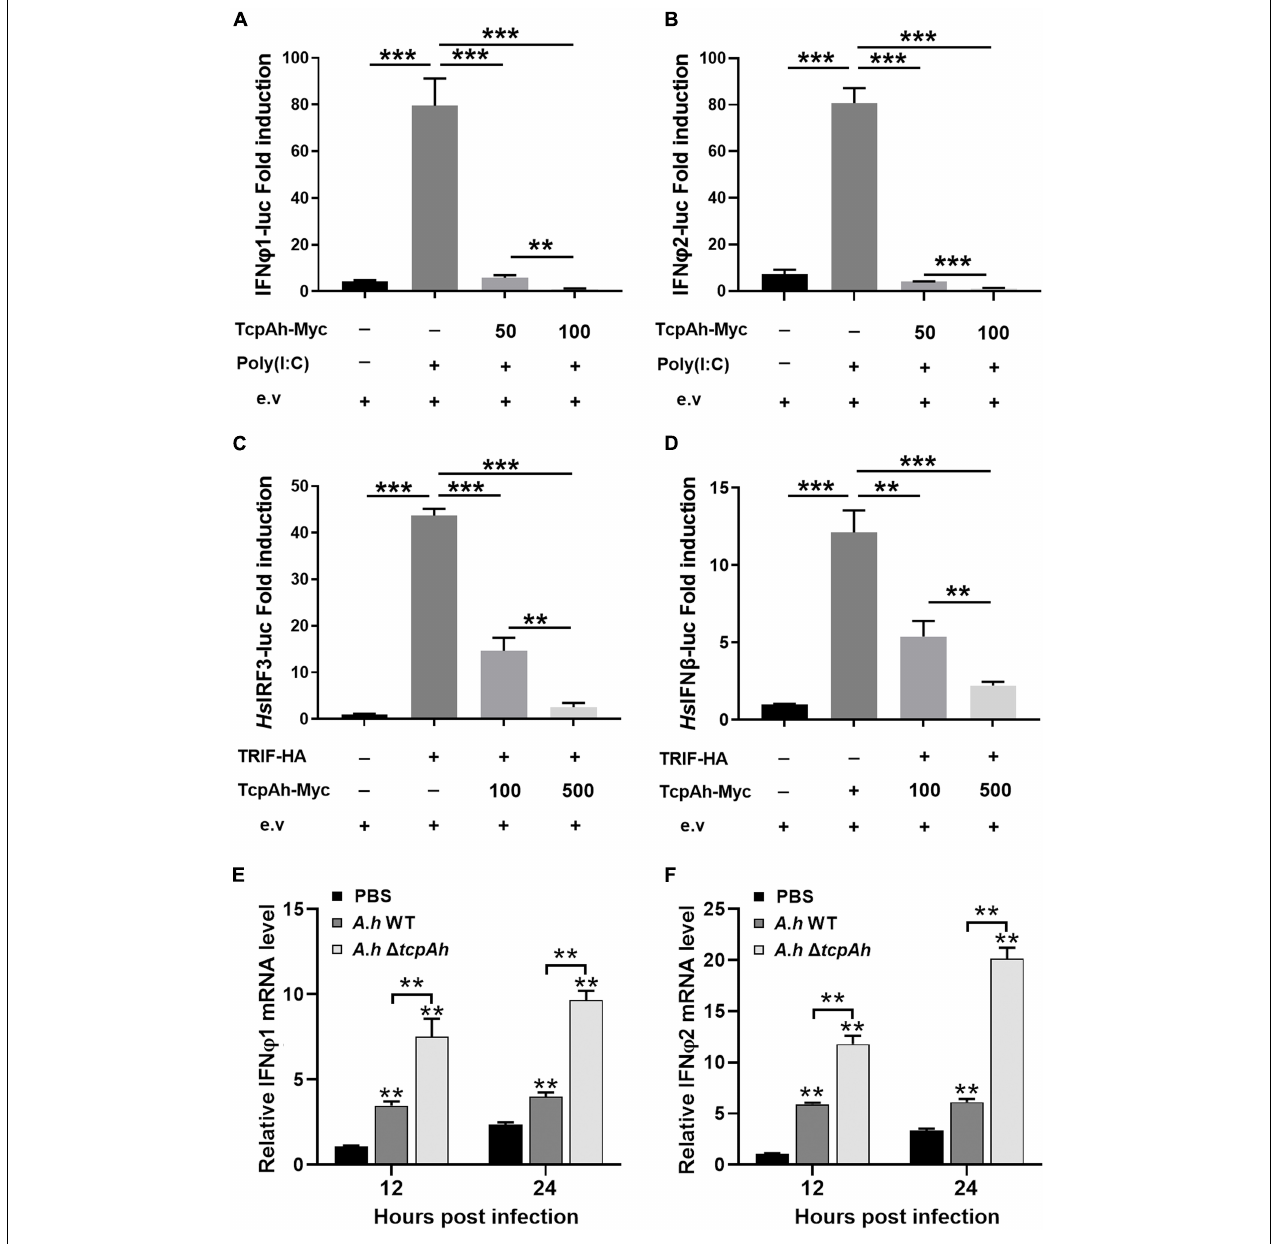
FIGURE 5 | Examination of the inhibitory role of TcpAh in TRIF signaling pathway. (A,B) Activation of zebrafish IFN ϕ 1/IFN ϕ 2 promoters detected in zebrafish embryos microinjected with IFN ϕ 1 or IFN ϕ 2 luciferase reporter (IFN ϕ 1 or IFN ϕ 2-Luc; 100 pg/embryo), renilla luciferase reporter (10 pg/embryo), and increasing amounts (0, 50, and 100 pg/embryo) of TcpAh expression vectors under stimulation with PolyI:C (200 pg/embryo) for 12 h. Data are the average luciferase activity ± SD (** p < 0.01; *** p < 0.001). (C,D) Activation of human IRF3 and IFN- β promoters in HEK293T cells transfected with human IRF3 or IFN- β luciferase reporter (IRF3-Luc or IFN- β -Luc; 200 ng/mL), renilla luciferase reporter (15 ng/mL), zebrafish TRIF expression vector (50 ng/mL), and increasing amounts (0, 100, and 500 ng/mL) of TcpAh expression vectors. Data are the average luciferase activity ± SD (** p < 0.01; *** p < 0.001). (E,F) Real-time PCR analysis for the expression of zebrafish IFN ϕ 1 (E) and IFN ϕ 2 (F) in leukocytes, which were sorted from peripheral blood, spleen, and kidney tissues at indicated time after i.p. stimulation with PBS, wild-type A. hydrophila and (cid:49) tcpAh mutant. Data are representative of three independent experiments as mean ± SD (** p < 0.01). Standard loading was indicated by β -actin